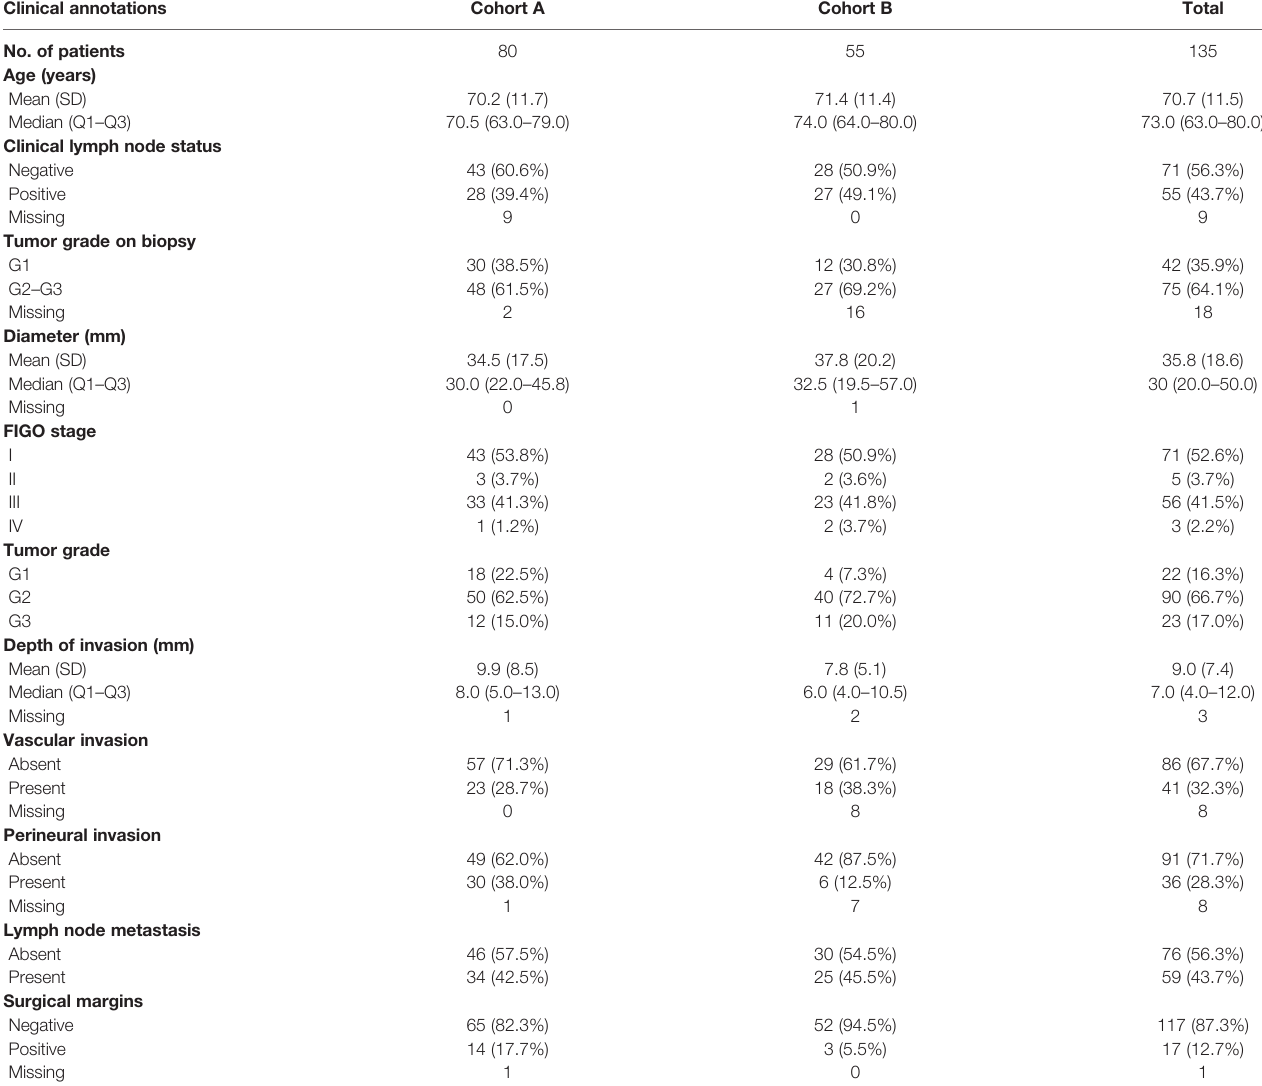
TABLE 1 | Clinical characteristics of vulvar squamous cell carcinoma (VSCC)